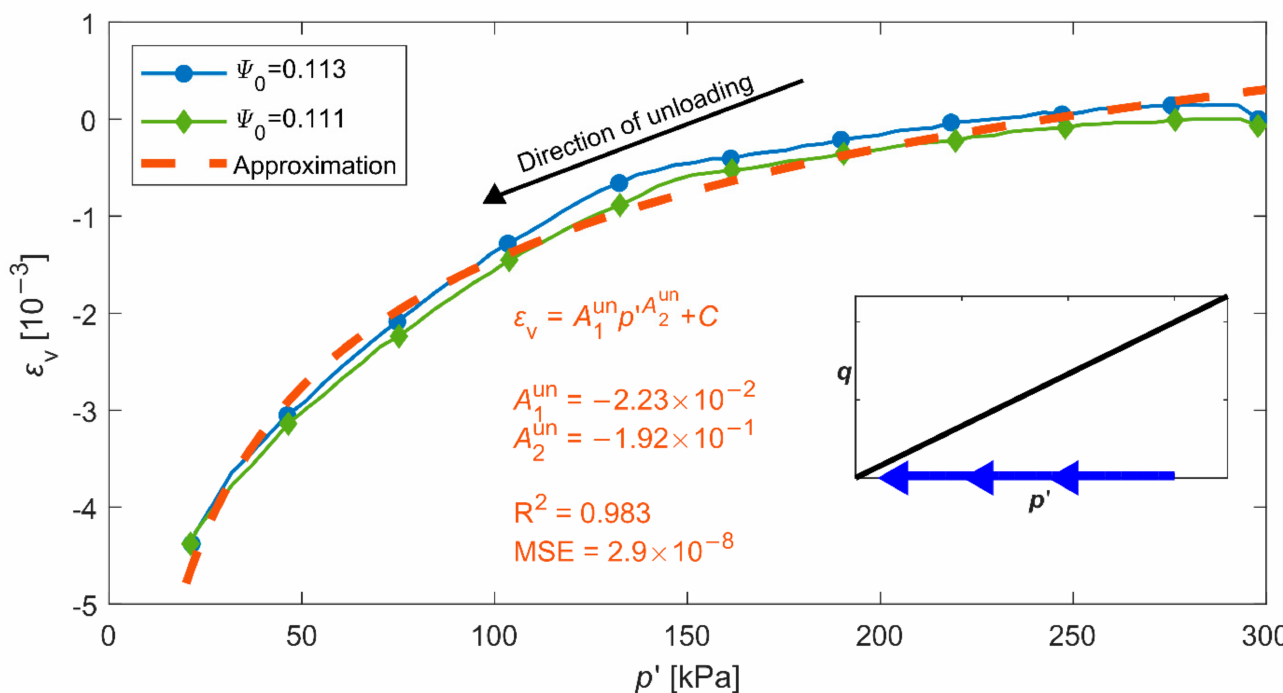
Figure 17. Volumetric strains developing during isotropic unloading in OZM50